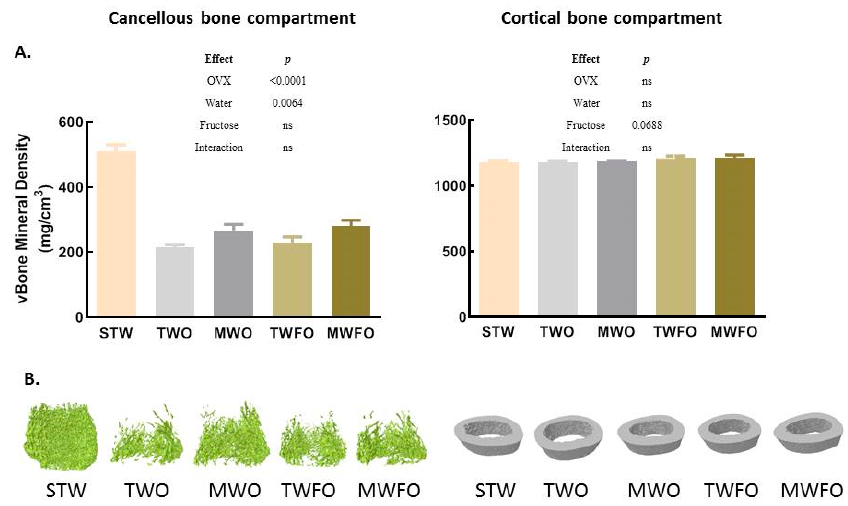
Figure 1. Volumetric bone mineral density of rat cancellous and cortical compartments of distal femur by microcomputed tomography. ( A ) Quantification of volumetric bone mineral density (mg / cm 3 ). ( B ) Representative images of the compartments used for quantification of volumetric bone mineral density. MWFO: ovariectomized caesarean-derived (CD) Sprague Dawley rats with access to 10% 234 fructose in natural mineral-rich water; MWO: ovariectomized CD Sprague Dawley rats with access to 235 natural mineral-rich water; ns: nonsignificant; OVX: ovariectomy; STW: sham-operated CD Sprague 236 Dawley rats with access to tap water; TWFO: ovariectomized CD Sprague Dawley rats with access to 237 10% fructose in tap water; TWO: ovariectomized CD Sprague Dawley rats with access to tap water; 238 vBone: volumetric bone. Results are presented as mean ± standard deviation (after mild outlier 239 rejection: 5 ≤ n ≤ 6). Two-way analysis of variance (ANOVA), followed by Tukey multiple comparison 240